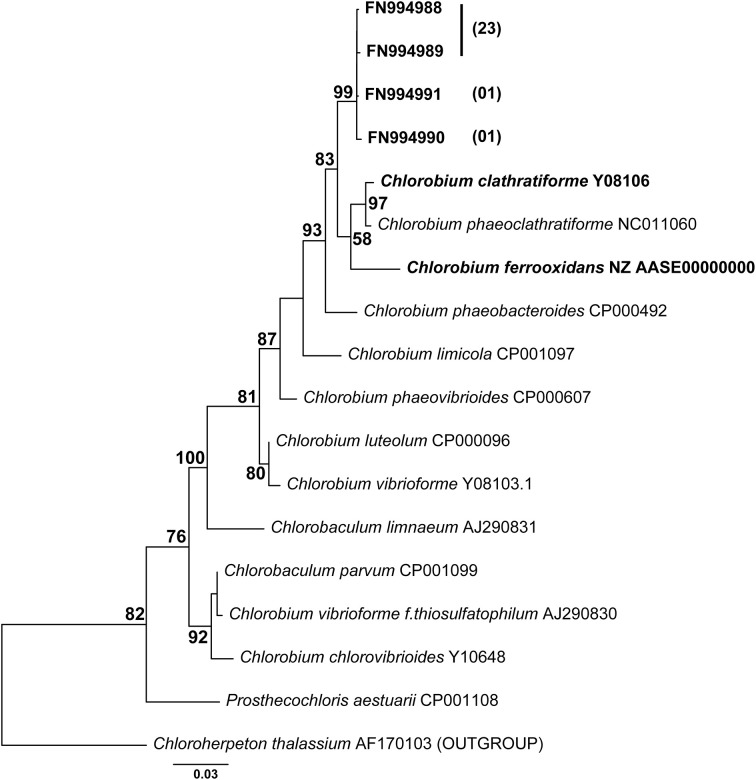
Phylogeny of the photoferrotrophic enrichment culture based on nearly complete 16S rRNA gene sequences and maximum likelihood analysis. Among the retrieved sequences 80% formed a well-defined cluster within the Chlorobia (25/31 clones), phototrophic green sulfur bacteria; the rest of the sequences were most closely related to uncultivated Acidobacteria (5/31 clones). Numbers in brackets signify the number of clones possessing the same sequence. Bootstrap values >50% for 1000 replications are shown.